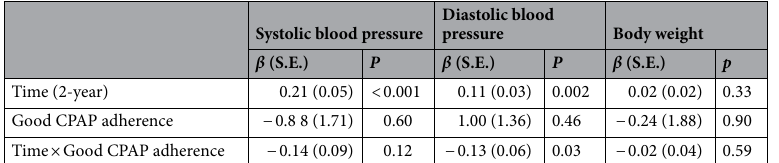
2. Multivariate-adjusted β estimates for blood pressure and body weight associated with CPAP adherence. S.E. standard error; Good CPAP adherence, using CPAP for more than 4 h ≥ 70% of the 30 days prior to all follow-up points. Model was adjusting for age, sex, alcohol consumption, smoking, medication history of hypertension, medication history of diabetes, medication history of dyslipidemia, baseline body weight, and baseline Epworth Sleepiness Scale.